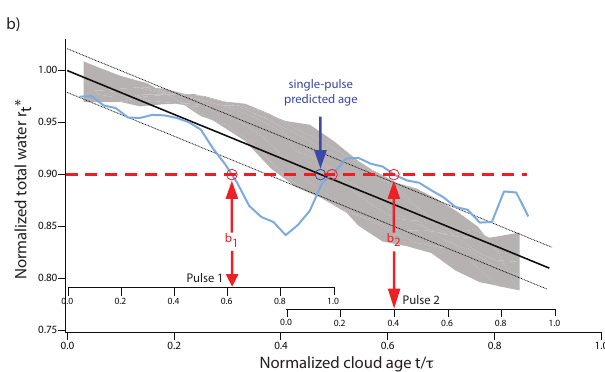
Figure 11. A cloud-averaged r ∗ t time series for a double-pulse cloud. The solid black line is the single-pulse fit, the dashed black lines are the fit t/τ ± 0 . 1, and the gray area envelops the single-pulse cloud data. The Pulse 1 and Pulse 2 time axes show the independent pulse ages associated with times b 1 and b 2 , respectively.